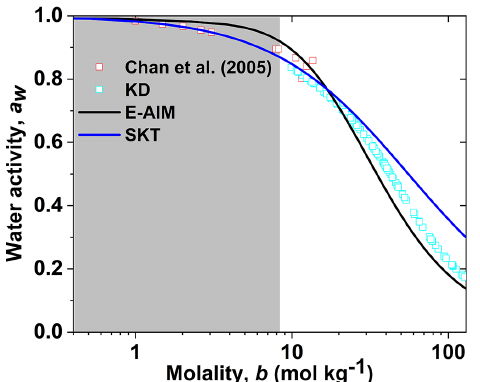
Figure 3. Hygroscopic diameter growth factor ( G f ) of levoglucosan particles with a dry diameter of 100nm in both deliquescence and efflorescence mode processes (black solid square). The measured data compared with literature data from Mochida and Kawmura (2004) in both deliquescence and efflorescence modes (red open square), Chan et al. (2005) in the deliquescence mode (magenta open square), Svenningsson et al. (2006) in the deliquescence mode (violet open square), and Mikhailov et al. (2008) in both deliques- cence and efflorescence modes (cyan open